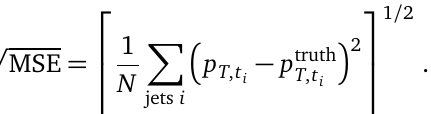
Figure 3: Correlation between the fat jet’s p between the extracted p shown with initial state radiation in the training and test samples switched